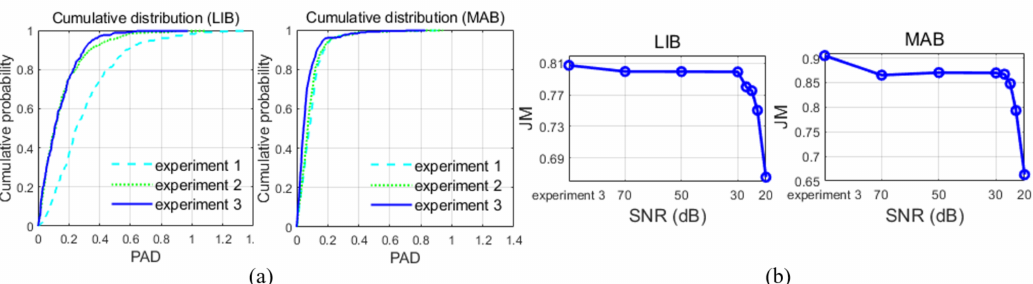
Figure 6. ( a ) The cumulative distributions of the percentage of area di ff erences (PADs) in the three experiments. ( b ) The performance of the superpixel-wise fuzzy clustering technique modified by edges, followed by level set evolution (SFCME-LSE) method on images with di ff erent signal-to-noise ratio